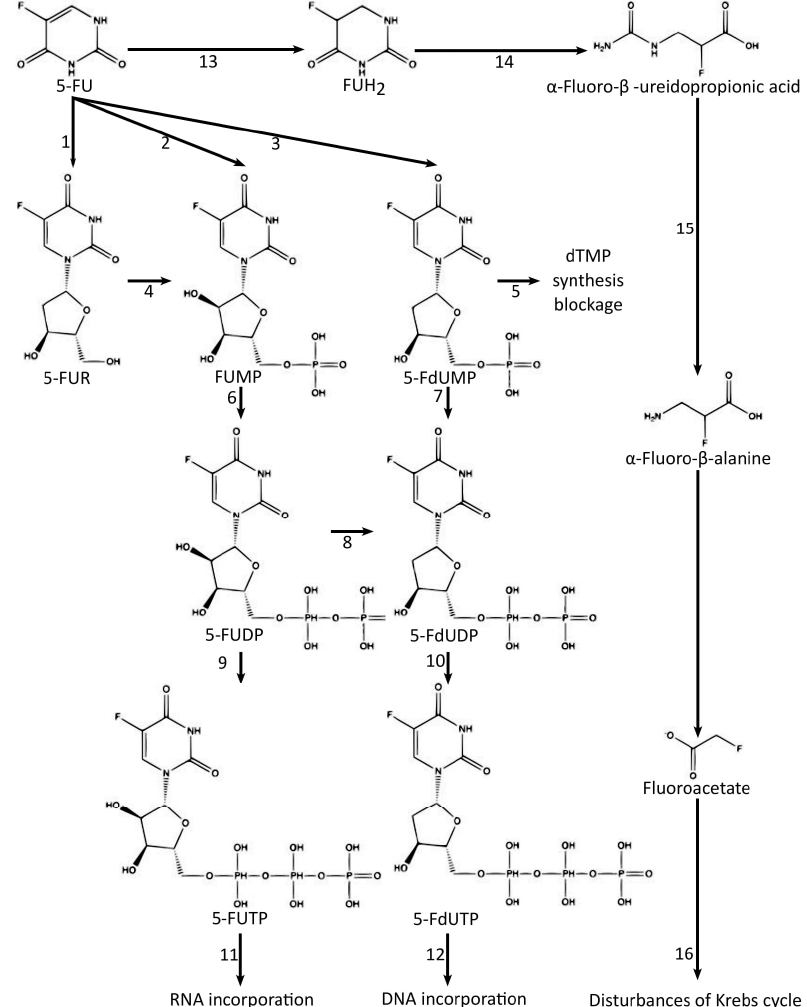
Figure 4. Metabolism of 5-fluorouracil. 1—UrdPase, uridine phosphorylase; 2—OPRT, orotate phos- phoribosylotransferase; 3—dThdPase, thymidine phosphorylase and TK, thymidine kinase; 4—UK, uridine kinase; 5—thymidylate synthase; 6—uridine monophosphate kinase; 7—deoxyuridine